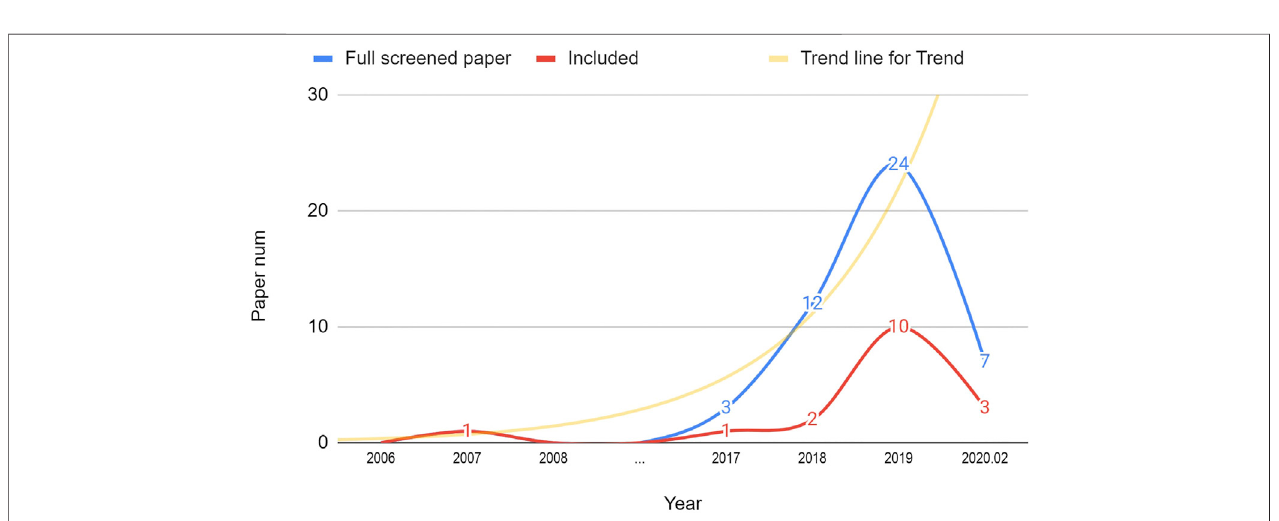
FIGURE 2 | Number of screened and included studies published in the given